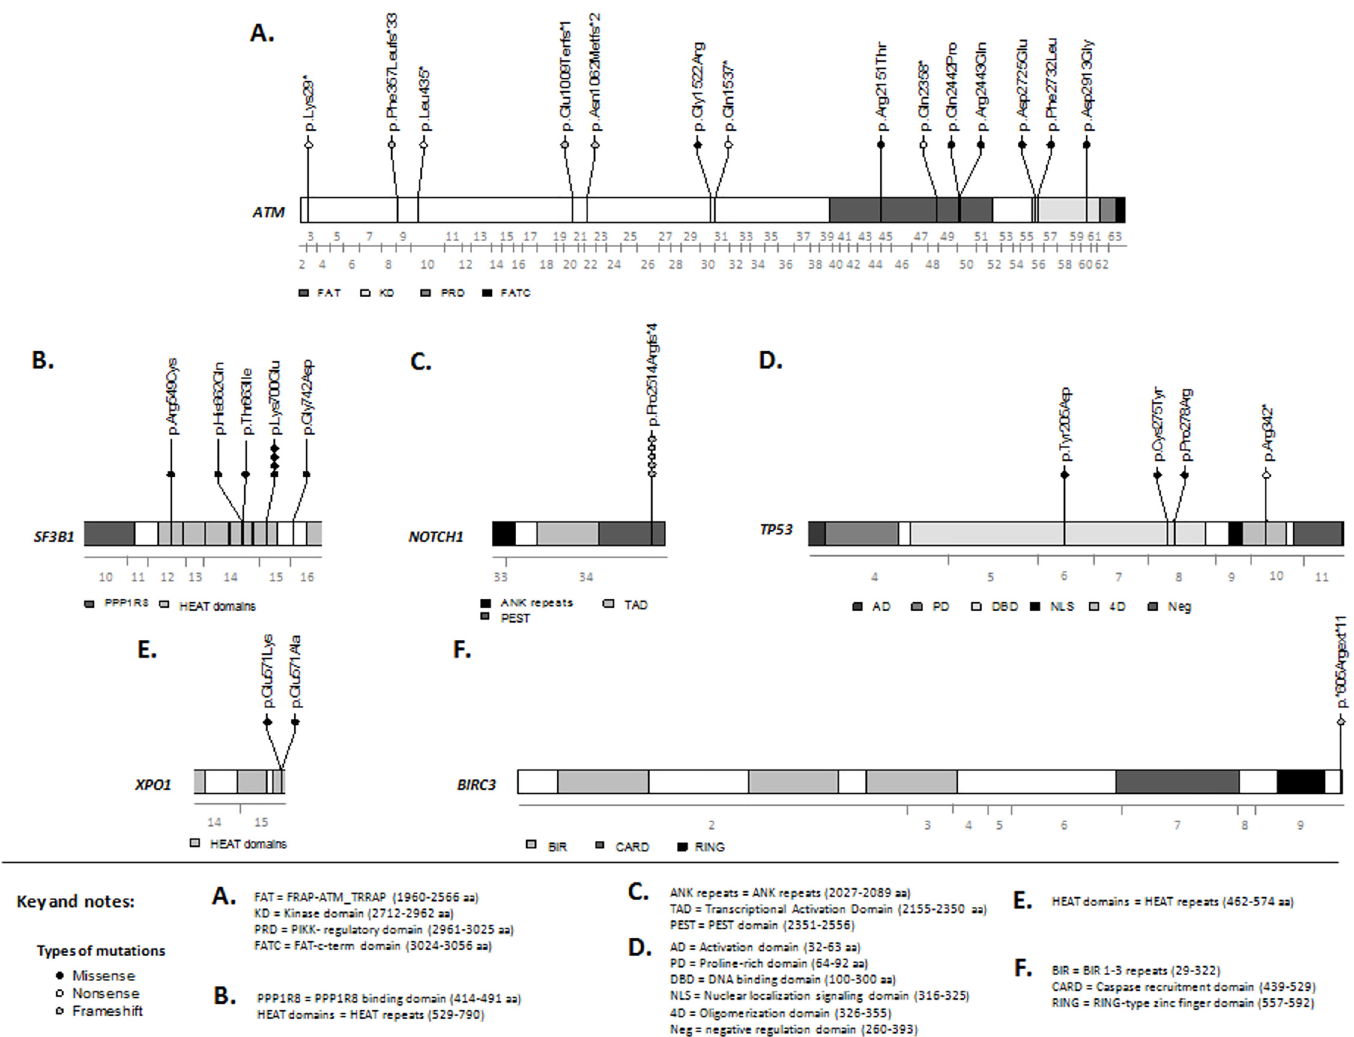
Fig 2. Localization and frequencies of mutations in ATM , SF3B1 , NOTCH1 , TP53 , XPO1 and BIRC3 genes. Mutations are indicated at the amino-acid level; each detected alteration is represented by a dot. Mutation type is represented by a dark (missense), white (nonsense) or grey (frameshift) dot. The sequenced exons for each gene are represented with a grey line below each schematic protein